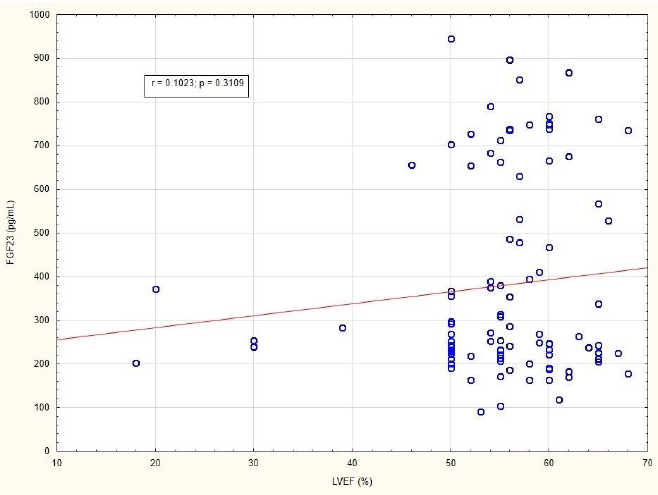
Figure 5. Correlation between LVEF and FGF23 level in patients with long-standing type 2 diabetes mellitus. Abbreviations: LVEF, left ventricular ejection fraction; FGF23, fibroblast growth factor 23. As shown in Table 3, patients with overt IHD had higher values of the following parameters: left ventricular end systolic volume (LVESV) ( p = 0.007), left ventricular end diastolic volume (LVEDV) ( p = 0.009), left ventricular mass index (LVMI) ( p = 0.004), left atrium (LA) volume ( p = 0.0002), left atrial volume index (LAVI) ( p = 0.0003), and tricuspid annular plane systolic excursion (TAPSE) ( p = 0.008). Table 3. Transthoracic echocardiographic parameters.